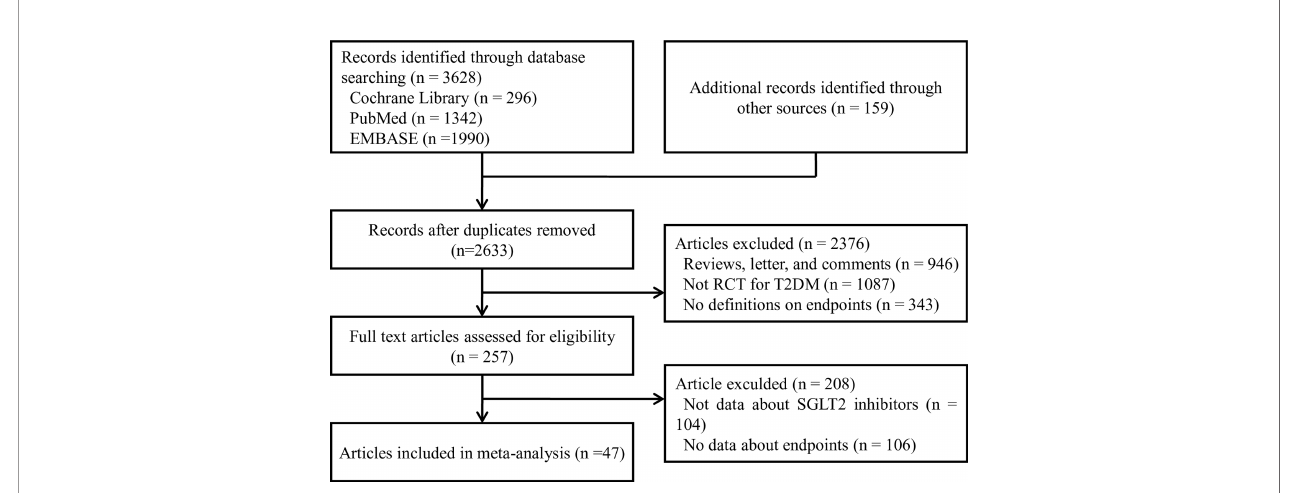
FIGURE 1 | PRISMA diagram of the study selection process for the meta-analysis.